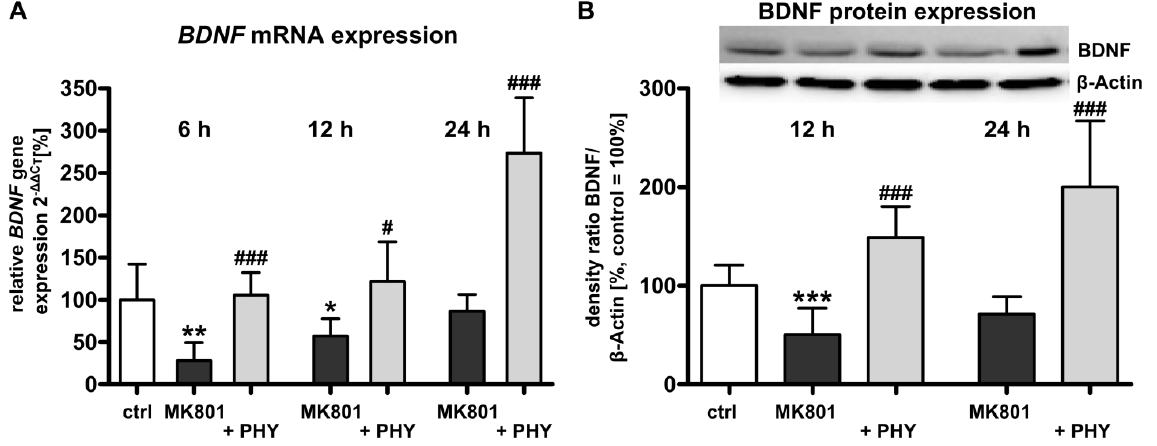
Figure 2. Increased brain-derived neurotrophic factor (BDNF) expression after physostigmine co-treatment in MK801 treated rat pups. ( A ) Quantitative analysis of brain BDNF mRNA expression at 6, 12 and 24 h after MK801 treatment (dark grey bars) with or without systemic physostigmine co-application (light grey bars); and ( B ) Quantitative protein expression of BDNF at 12 and 24 h after MK801 treatment (dark grey bars) in combination with AChE inhibition (light grey bars). The densitometric data represent the ratio of the pixel intensities of BDNF signals to the corresponding β-actin signals. Data are normalized to levels of vehicle treated pups ((control; white bar, 100%); bars represent mean + SD, n = 6–7 per group, *** p < 0.001, ** p < 0.01, * p < 0.05 compared to vehicle treated pups, ### p < 0.001, # p < 0.05 compared to MK801 treated pups, respectively). ctrl: control; PHY: